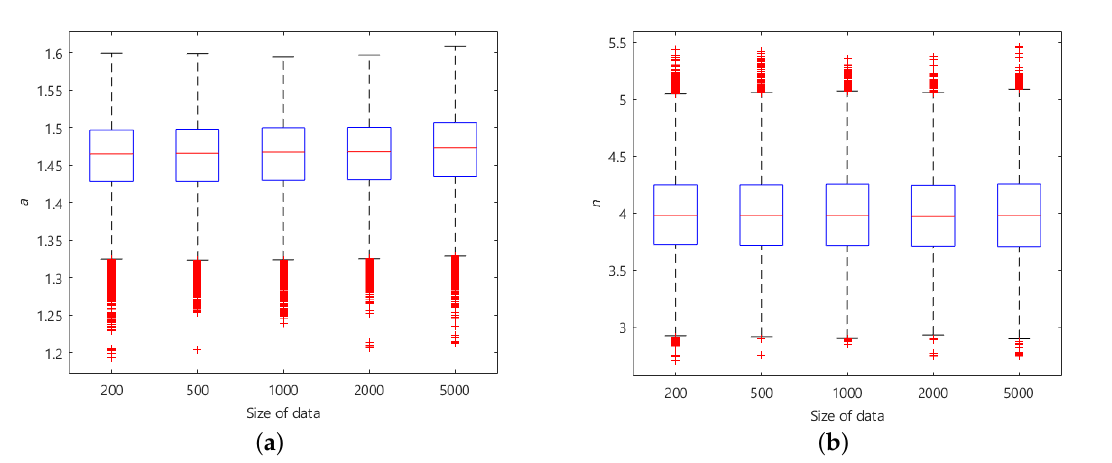
Figure 11. Impact of data volume on update results: ( a ) Parameter a ; ( b ) parameter n